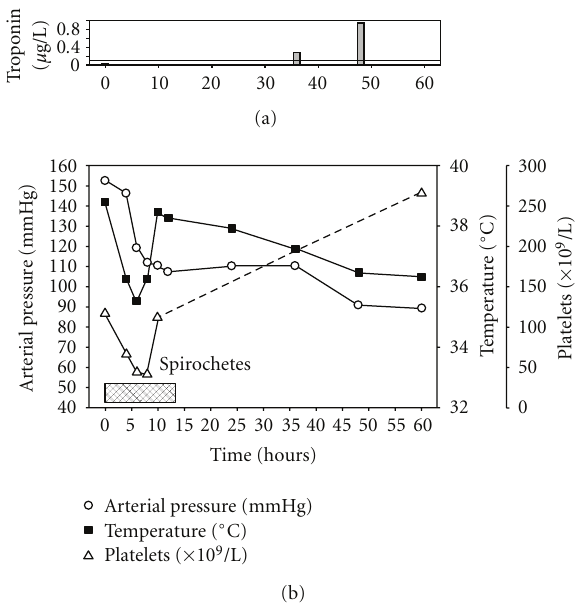
Figure 2: Time course of Jarisch-Herxheimer reaction (J-HR) in relapsing fever. Antimicrobial therapy was started at time 0. Symp- toms of rapid decrease in temperature, hypotension, and throm- bocytopenia correlated with peripheral blood spirochete clearance (pattern). Sepsis resulted in elevated serum cardiac troponin without acute coronary syndrome at 36 and 48 hours compared to time